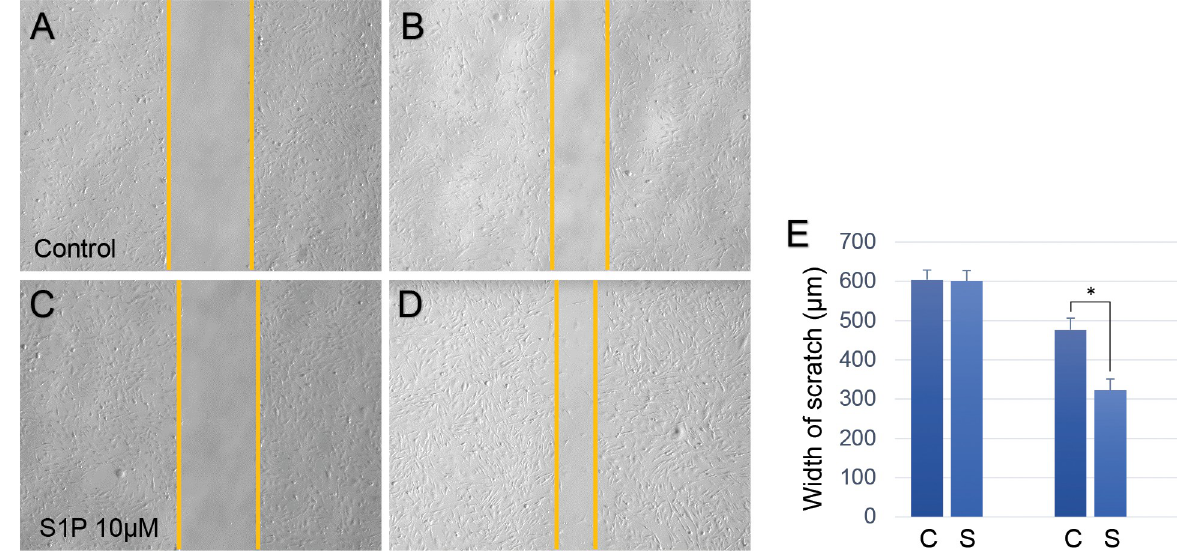
Fig 3. Results of the scratch test in human Muller glial cells. (A-D) Representative images of the control group at baseline (A) and 12 h later (B), sphingosine-1-phosphate (S1P) group at baseline (C) and 12 h later (D). (E) Bar graph that shows the results of the statistical analysis within groups (476.46 ± 30.03 μ m for control group, 322.67 ± 28.57 μ m for S1P group; p < 0.001). � p <